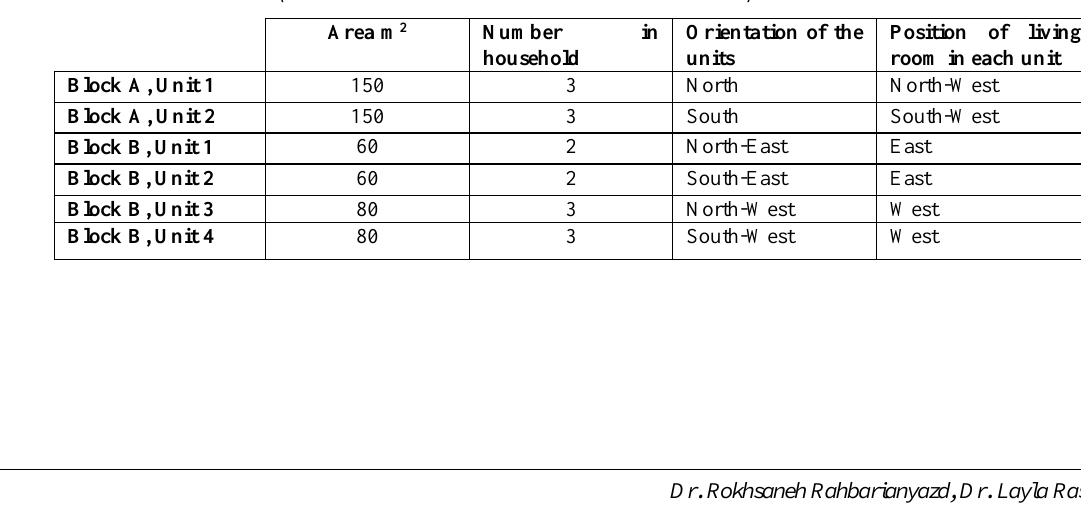
Table 1. Feature of selective units (area, orientation and also number in